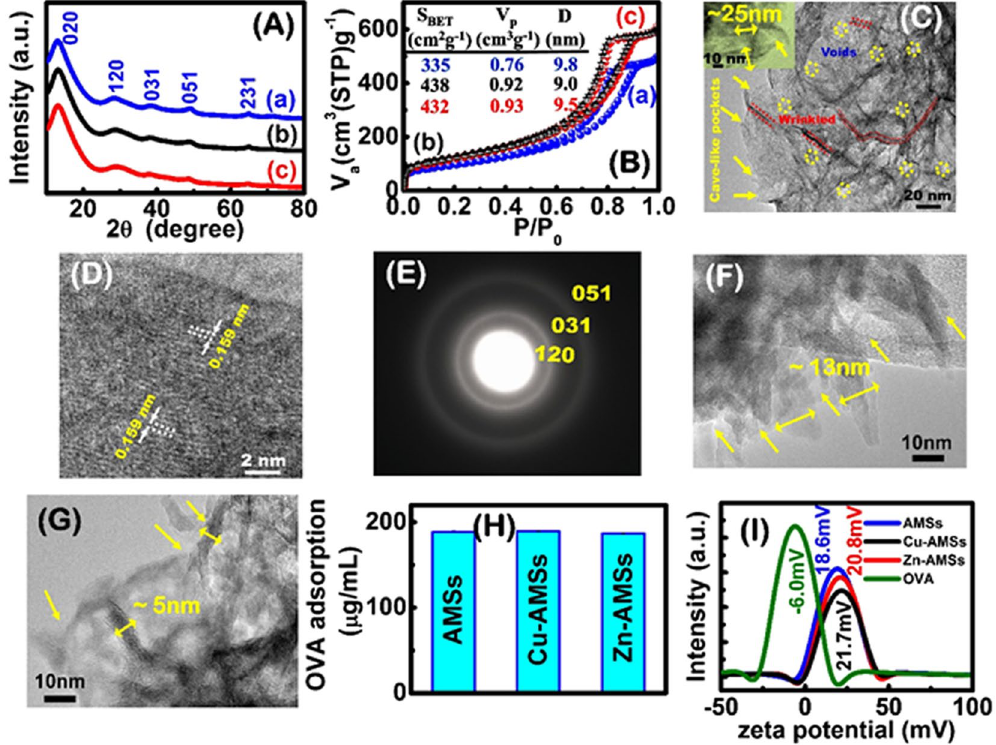
Figure 2. ( A ) Wide-angle X-ray diffraction (WAXRD) and ( B ) N 2 sorption isotherms and pore structure parameters (insert one) of hierarchical AMSs (a), Cu-AMSs (b) and Zn-AMSs (c). ( C–E ) TEM images ( C ), high-magnification TEM (HRTEM) image ( D ), and electron diffraction ( E ) of AMSs. ( F , G ) TEM images of Cu- AMSs ( F ) and Zn-AMSs (G ), respectively. ( H ) OVA adsorption onto different AMSs samples. ( I ) Zeta potential of OVA and hierarchical AMSs, Cu-AMSs and